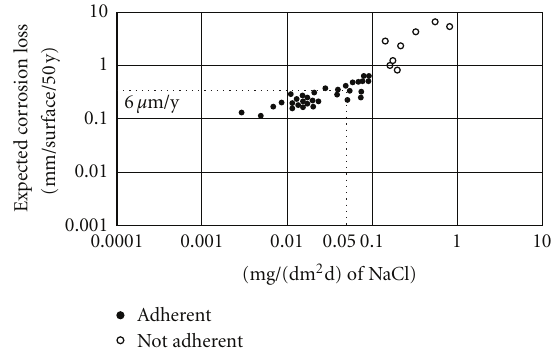
Figure 3: Influence of air-born salts (atmospheric salinity) on the stability of the protective layer of corrosion products formed on WS.